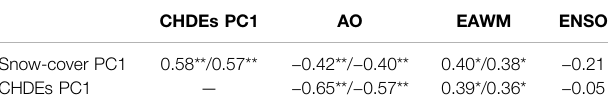
TABLE 1 | Correlation coef fi cients between the PC1s of winter snow cover, summerCHDEsandtheAO, EAWM, andENSO (Niño3.4) indicesinwinterfor 1981 – 2020. After/represents the correlation coef fi cient after removing ENSO. CHDEs PC1 AO